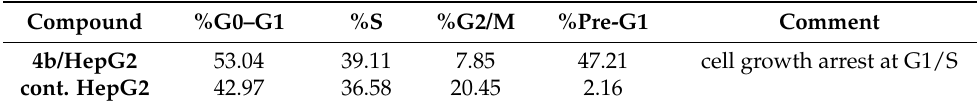
Table 4. Cell cycle analysis and apoptosis detection of hybrid 4b .